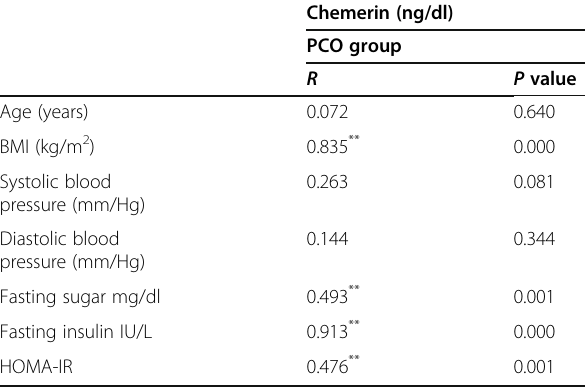
Table 8 Correlation between chemerin level and the other studied parameters in PCO group Chemerin (ng/dl) PCO group R P value Age (years) 0.072 0.640